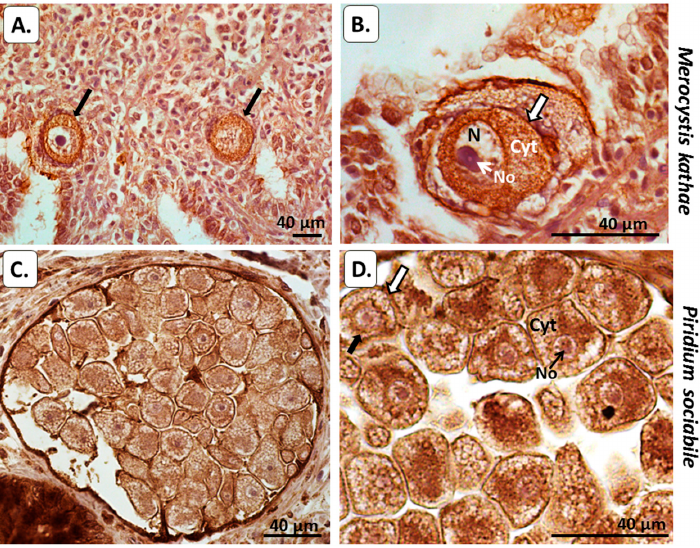
Figure 3. Peptidylarginine deiminase (PAD) in the two alveolates under study. ( A , B ) M. kathae in the kidney of a common whelk. ( A ) Two macrogamonts with strong PAD positive reaction detected in the cytoplasm (cyt) and in the cell membrane (black arrows). Surrounding host tissue (whelk kidney) is also PAD positive as expected. ( B ) Higher magnification of a representative macrogamont with prominent nucleus (N) and nucleolus (No); cell membrane highlighted by white arrow–strong positive PAD reaction is observed in M. kathae cytoplasm. ( C , D ) P. sociabile in the whelk foot. Numerous, encysted parasite bodies of P. sociabile ( C ) and several of these forms at higher magnification ( D ). The figures show strong PAD positive staining in the cytoplasm (cyt), the plasma (white arrow) and nuclear membrane (black arrow), and some low reaction in the nucleolus (No). The fibromuscular host tissue (whelk) is positive for PAD, as would be expected as PAD is strongly expressed in muscle. Scale bar is indicated in each figure and is 40 µm.